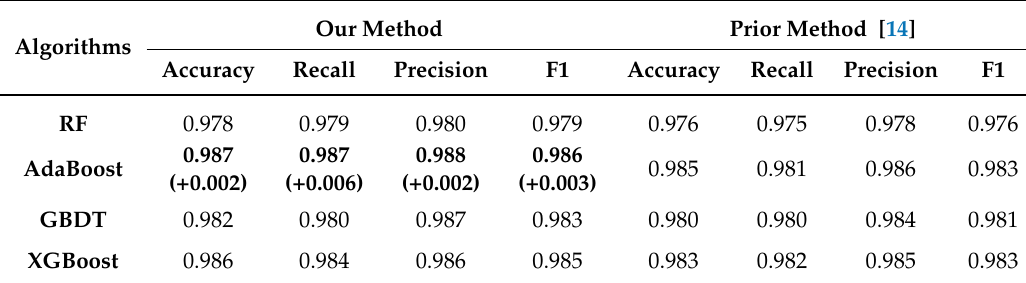
Table 6. Results of action identification on the WeChat app.